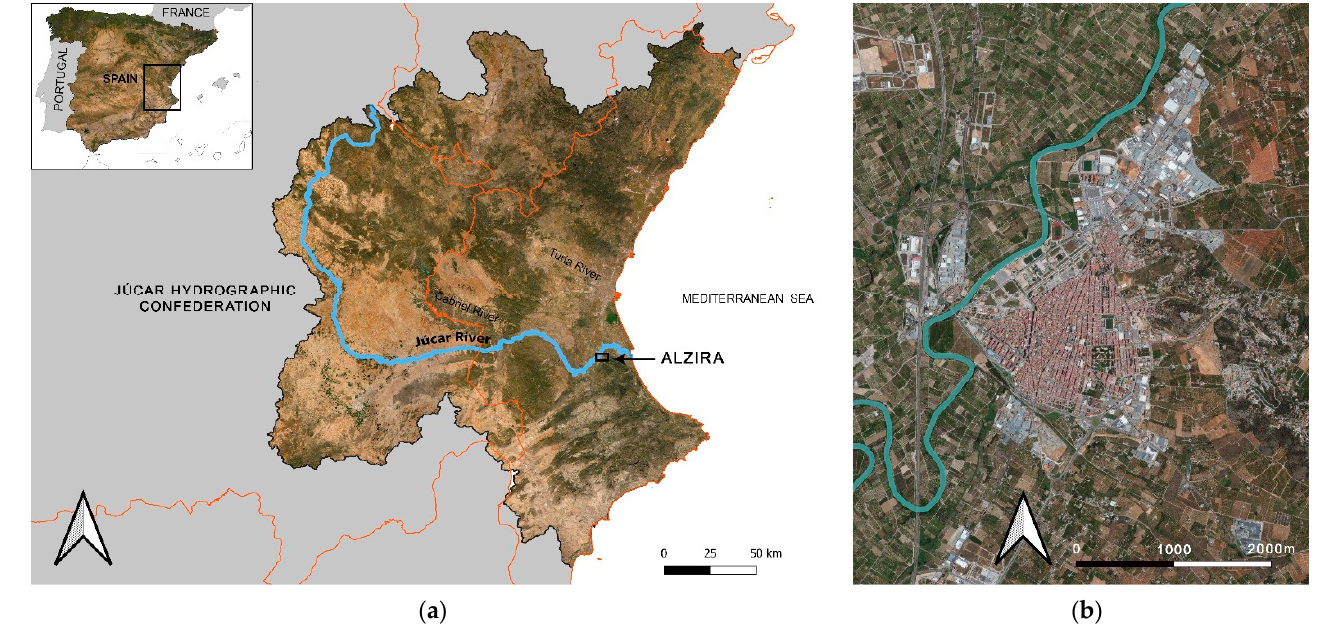
Figure 2. ( a ) Hydrographic outline of the Júcar; ( b ) The Júcar as it passes through Alzira.